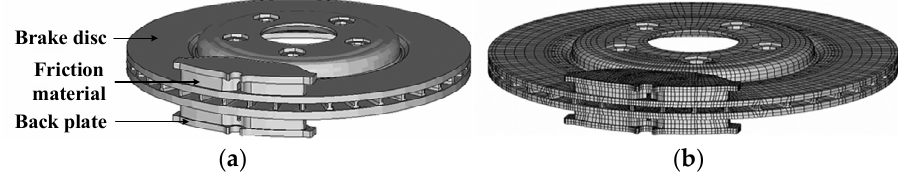
Figure 6. A vehicle disc brake system. ( a ) CAD model; ( b ) Finite element model.